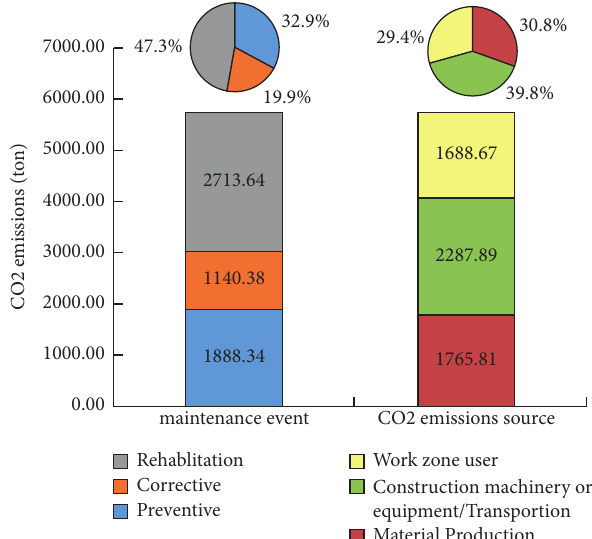
Figure 3: CO 2 emissions distribution of maintenance event and sources during the life cycle of highway pavement.